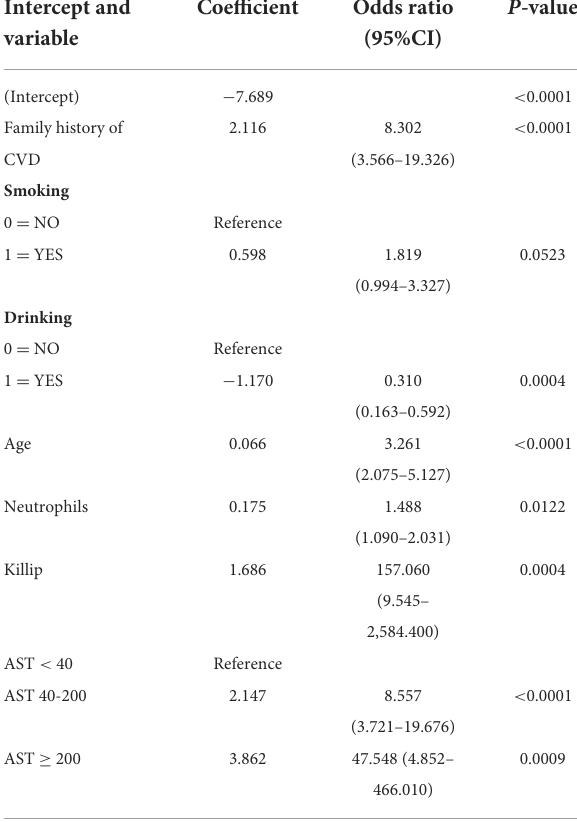
TABLE 2 Multivariate logistic regression